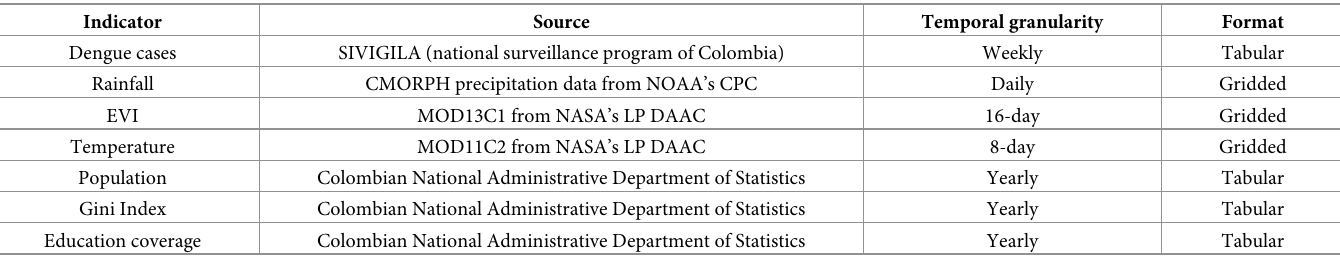
Table 1. Summary of indicators and data